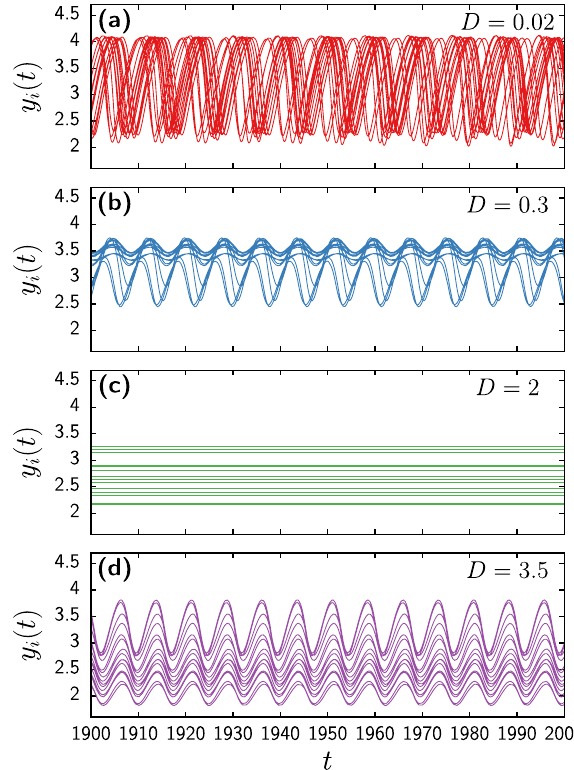
Fig. 2 Time series of individual nodes of the Brusselator system with random-walk diffusion. Each line indicates the time evolution of the y variable of node i , where i corresponds to 15 randomly chosen nodes (same nodes for each panel). Results obtained from the numerical integration of the Brusselator model Eq. (10) with random-walk diffusion Eq. (2) on an Erdös- Rényi networks of size N = 1000 and average degree 〈 k 〉 = 20. System parameters for the Brusselator reaction terms are a = 0.5, b = 1.7. The values of diffusion coef fi cient are a D = 0.02, b D = 0.3, c D = 2, and d D =